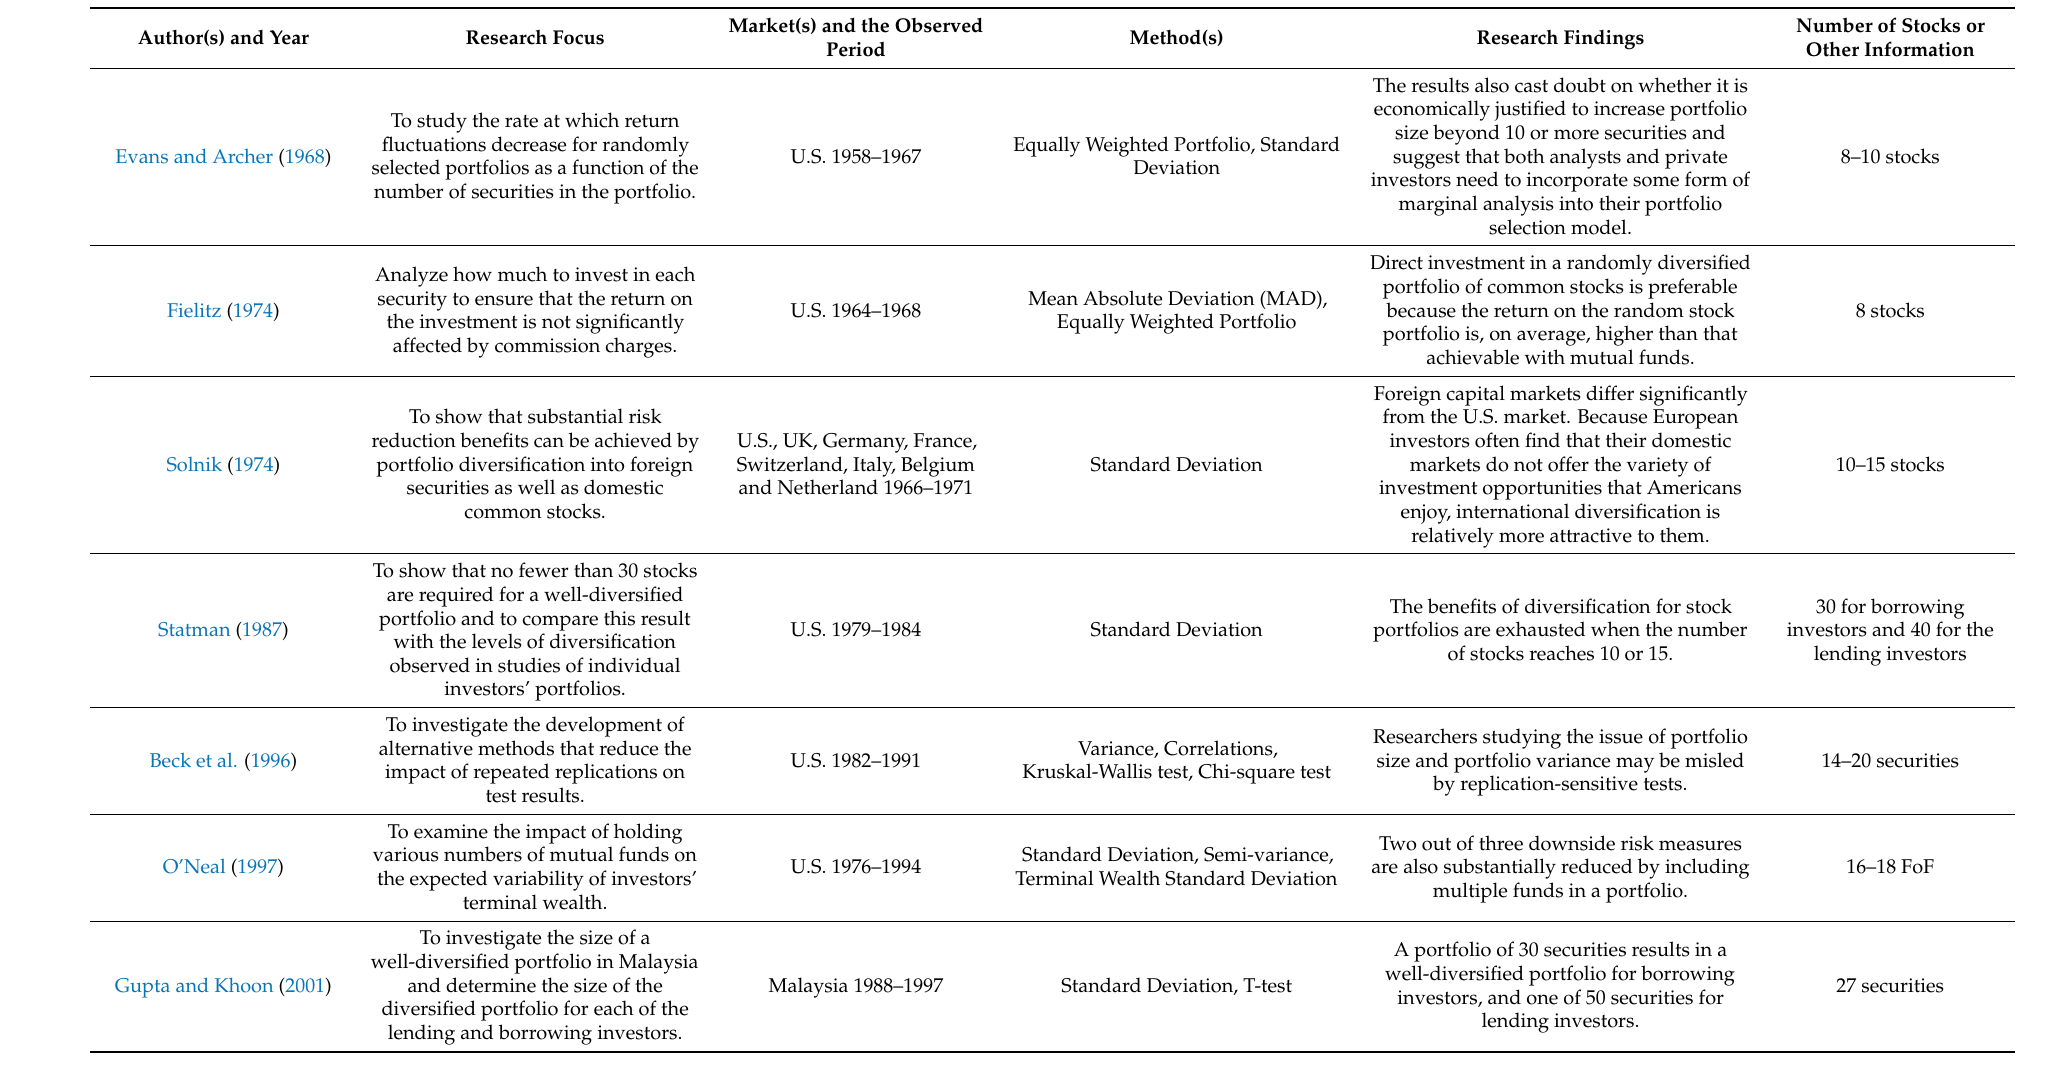
Table 1. Chronological overview of articles about the needed number of stocks for risk